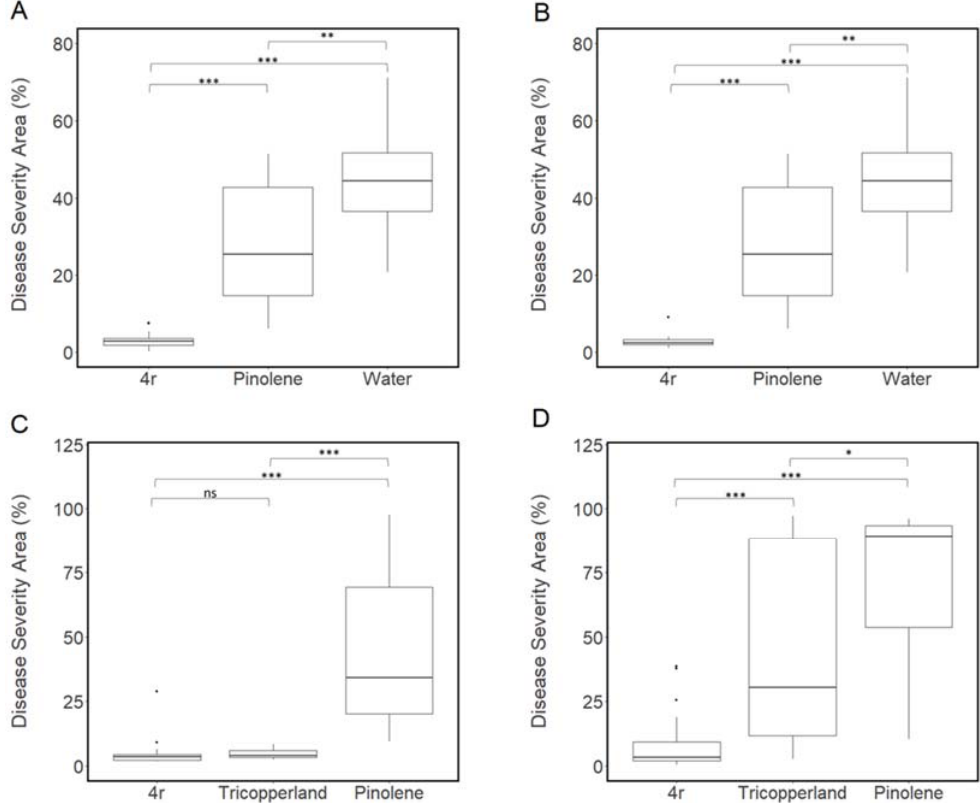
Figure 4. Boxplot of the Disease Severity Area (DSA) caused by Xanthomonas campestris pv. campestris (Xcc) inoculation on cauliflower cv. “Palla di neve” leaves, subjected to pre- ( A , C ); Xcc was inoculated after peptide solution had dried) or post-inoculation ( B , D ); peptide solution sprayed 24 h post Xcc inoculation) treatments with peptide 4r, supplemented with the adjuvant pinolene, in comparison to compositions with pinolene alone or with a tribasic copper sulfate formulation (Tricopperland; ( C , D )). For each treatment, 2 leaves of 3 plants were treated and inoculated. Data from three independent experiments were analyzed together. Asterisks indicate significant differences between the averages of the compared treatments based on a one-way ANOVA followed by Tukey’s honestly significant differences, “***” for p < 0.001, “**” for p < 0.01, and “*” for p < 0.05; ns = not significant. Actual values are plotted on boxplots; boxes range from the first quartile (Q1) to the third quartile (Q3), and the line across the box represents the median. Whiskers extend from Q3—1.5 (Q3 − Q1) to Q3 + 1.5 (Q3 − Q1). Outliers are represented as black dots.